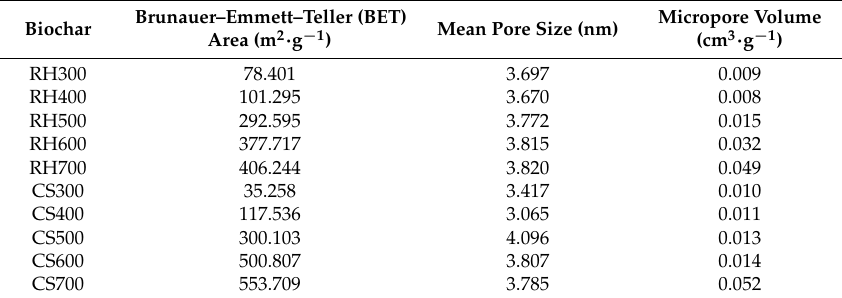
Table 3. Biochar specific surface area, mean pore size, and micropore volume for the materials obtained at various pyrolysis temperatures.